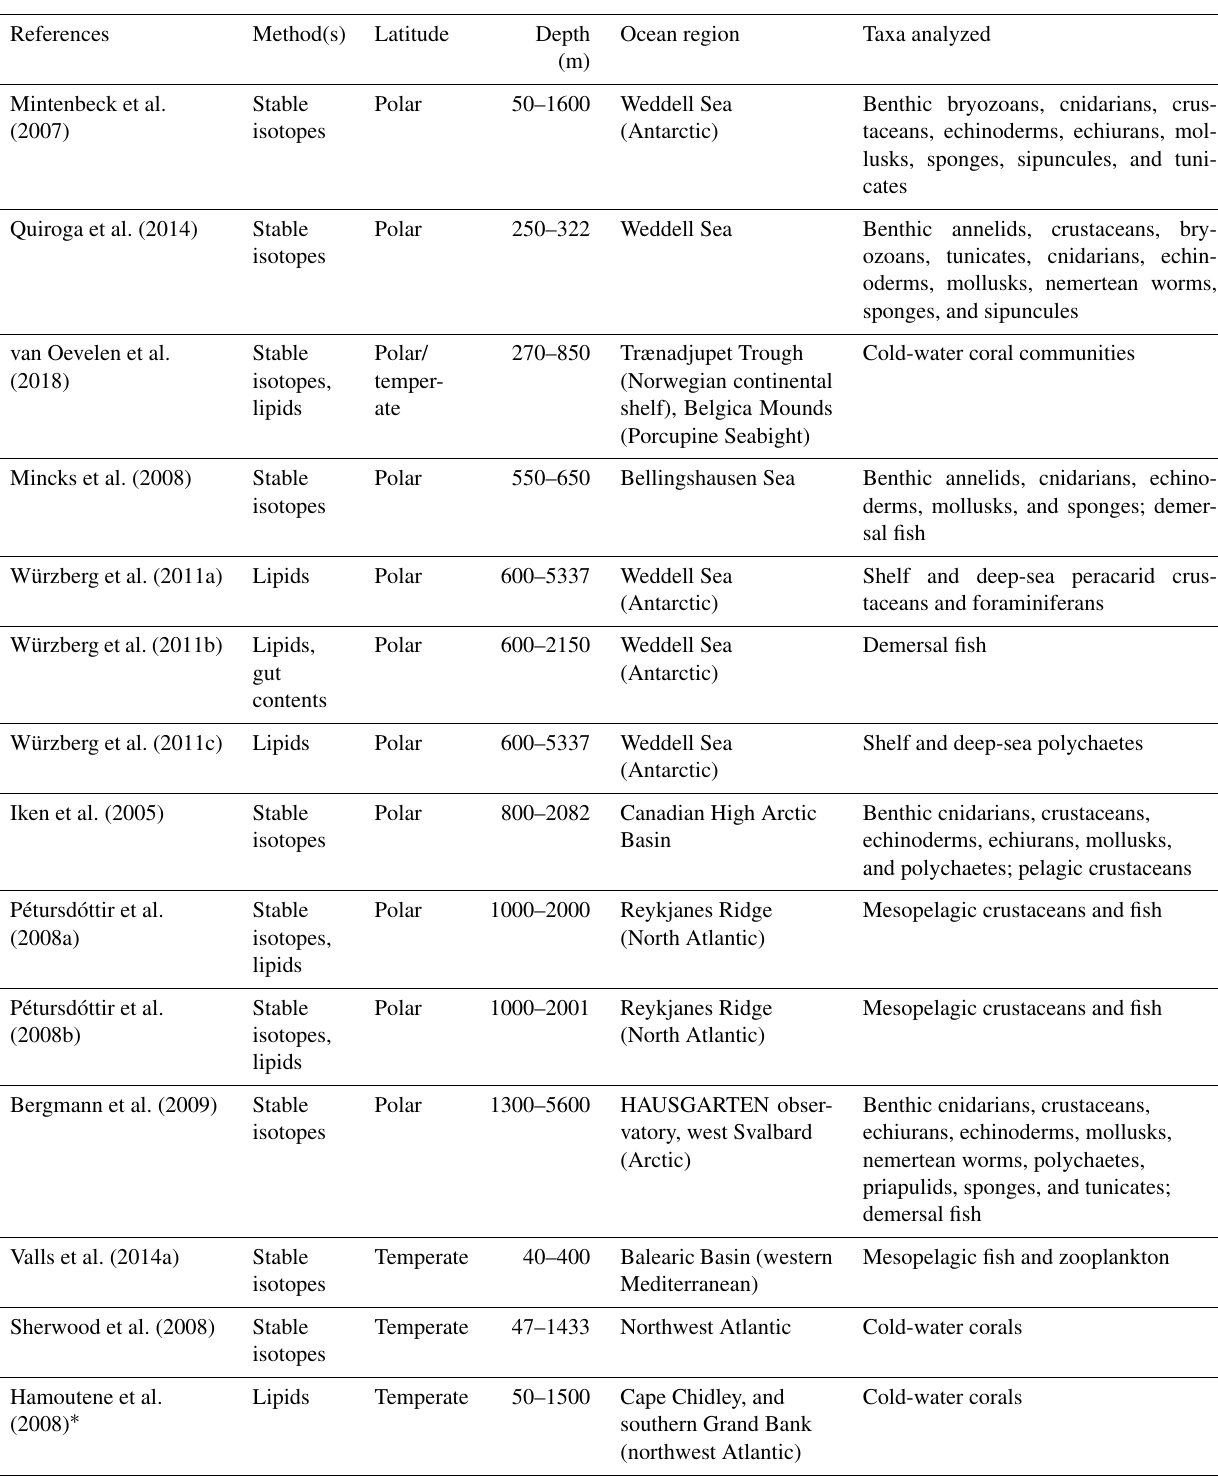
Table 3. List of trophic ecology studies in deep-sea heterotrophic systems, carried out using stable isotopes (bulk) and lipids (including FA) as food-web tracers. Experimental studies were excluded a priori. Reference, method(s) applied, latitude, sampling depth, ocean region, and taxa analyzed are reported for each study. Polar latitudes include investigations between 60 and 90 ◦ N or S, whereas temperate and tropical latitudes represent studies carried out within 0–30 and 30–60 ◦ N, respectively. References are ordered according to sampling